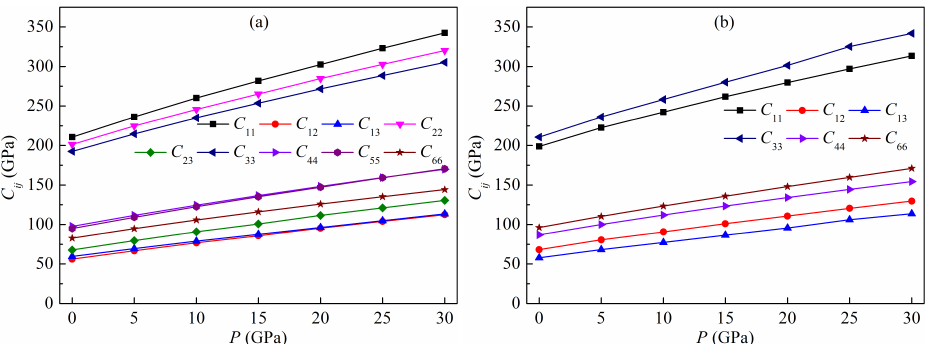
Figure 3. Elastic constants of the LPSs ( a ) h-Al 2 Ti and ( b ) r-Al 2 Ti as a function of pressure at 0